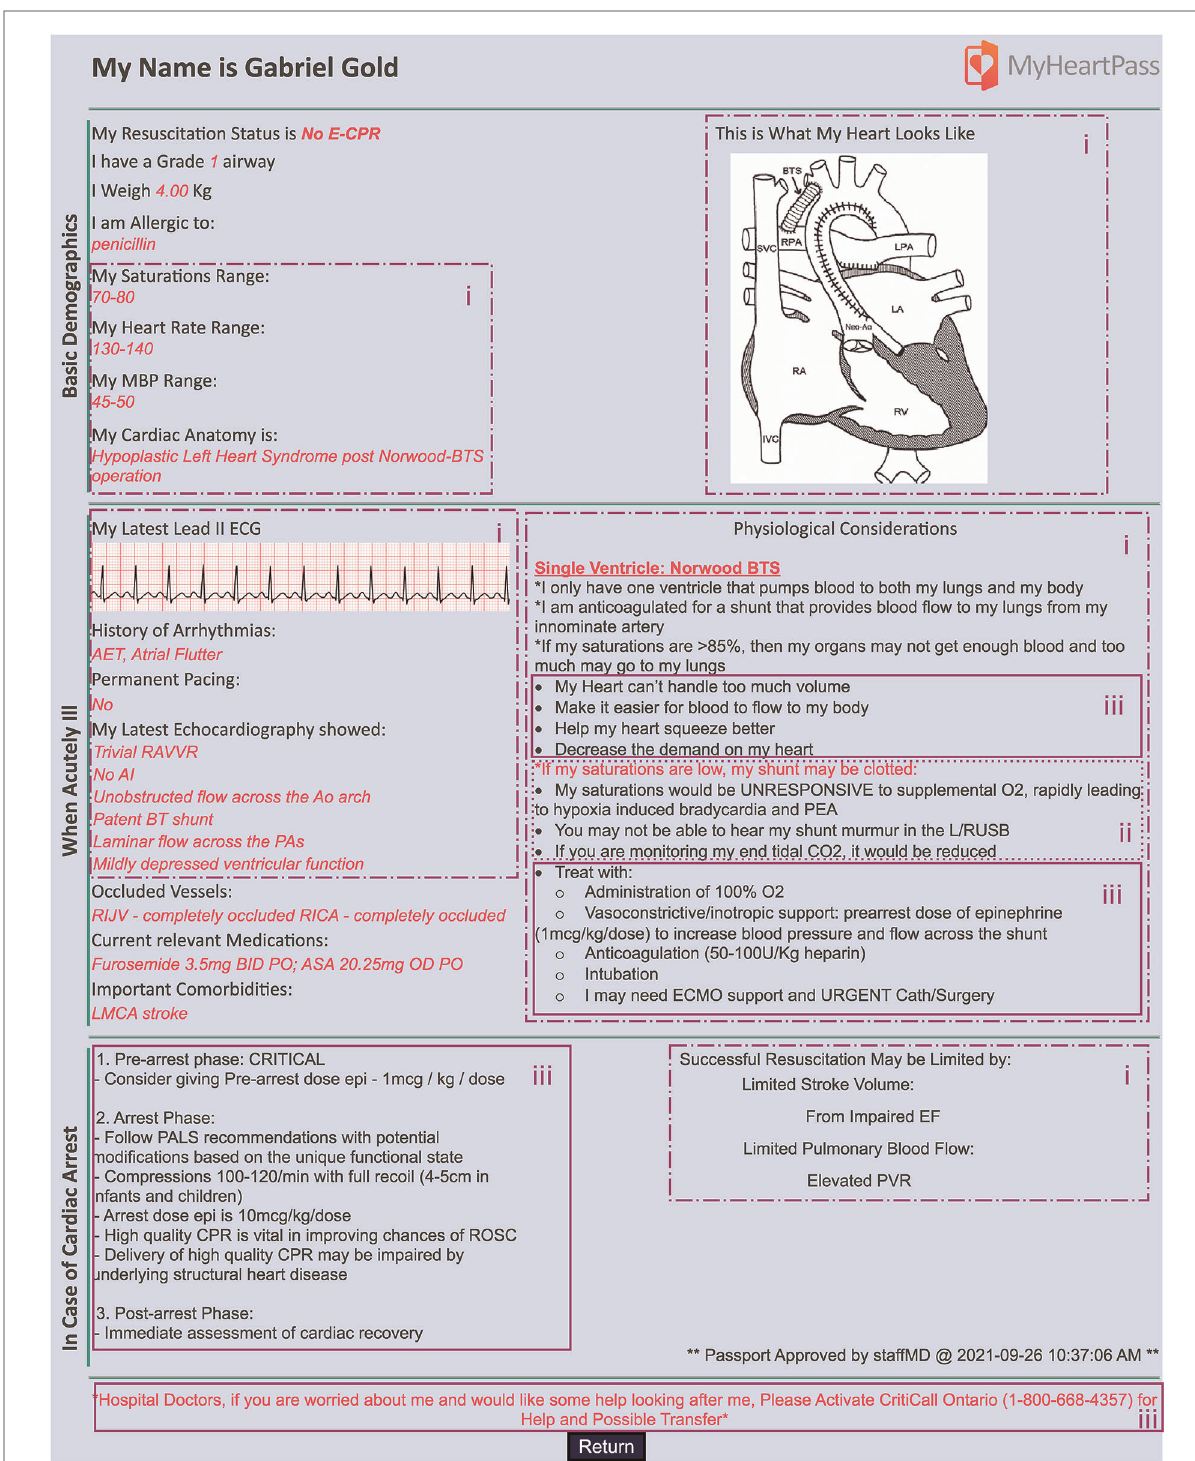
FIGURE 1 Screenshot of MyHeartPass ™ prototype. Sections marked with (i) refer to elements of design pertaining to key decision requirement distinguish the patient ’ s unique physiology based on their unique cardiac anatomy. Elements marked with (ii) capture the elements pertaining to the key decision requirement of explicitly consider CHD speci fi c differential diagnoses to allow a more structured re fl ection of diagnosis; and (iii) capture the elements pertaining to the key decision requirement of select CHD appropriate interventions for each patient